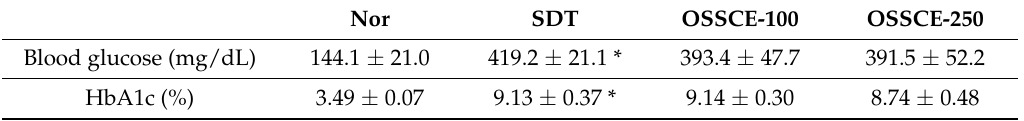
Table 1. The levels of HbA1c and blood glucose in SDT rats.